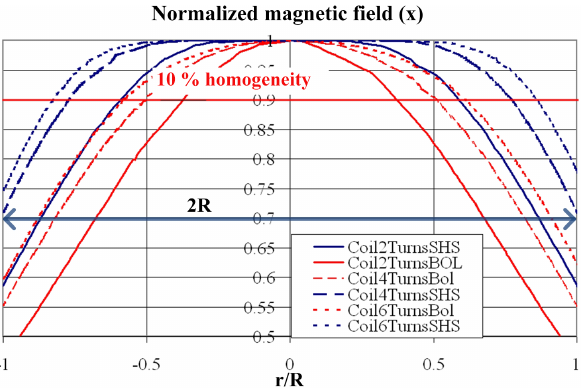
Figure 8. Magnetic field homogeneity profile on the x axis, com- parison between Everett–Bolinger coil and SHS coil for two, four and six